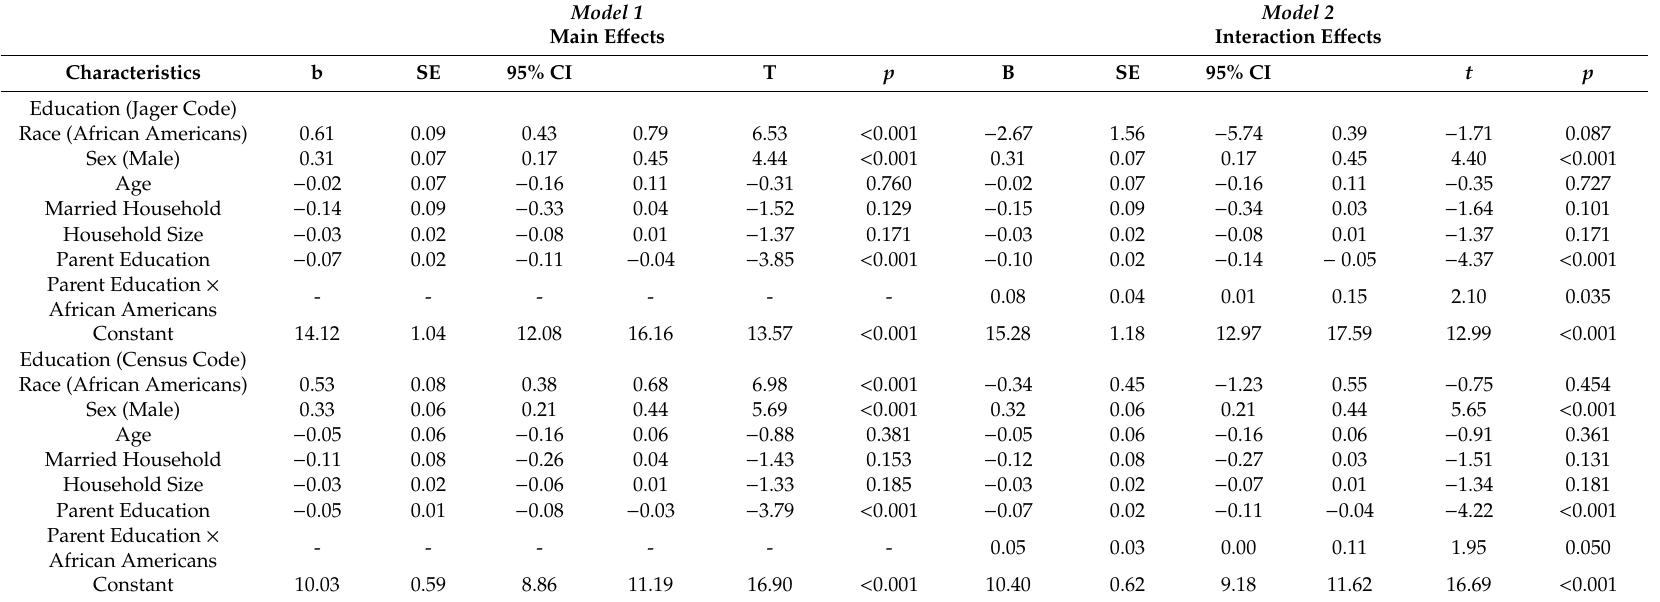
Table 2. Summary of linear regressions overall ( n =